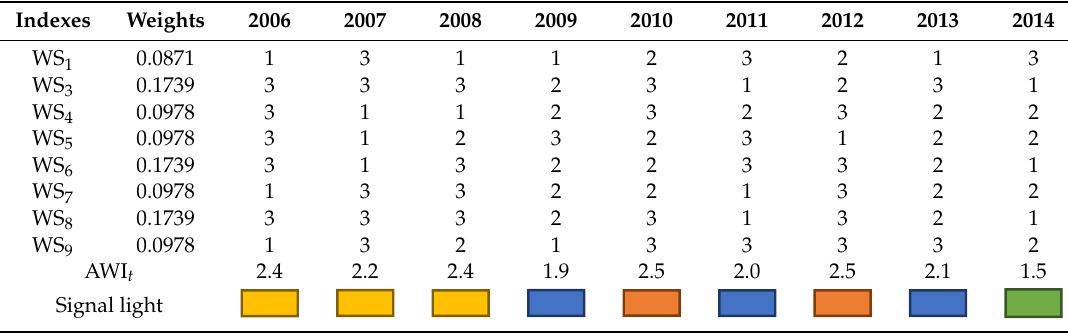
Table 7. Weights w s , warning signal values V ( s , t ), and AWI t values from 2006 to 2014 in Anhui Province.